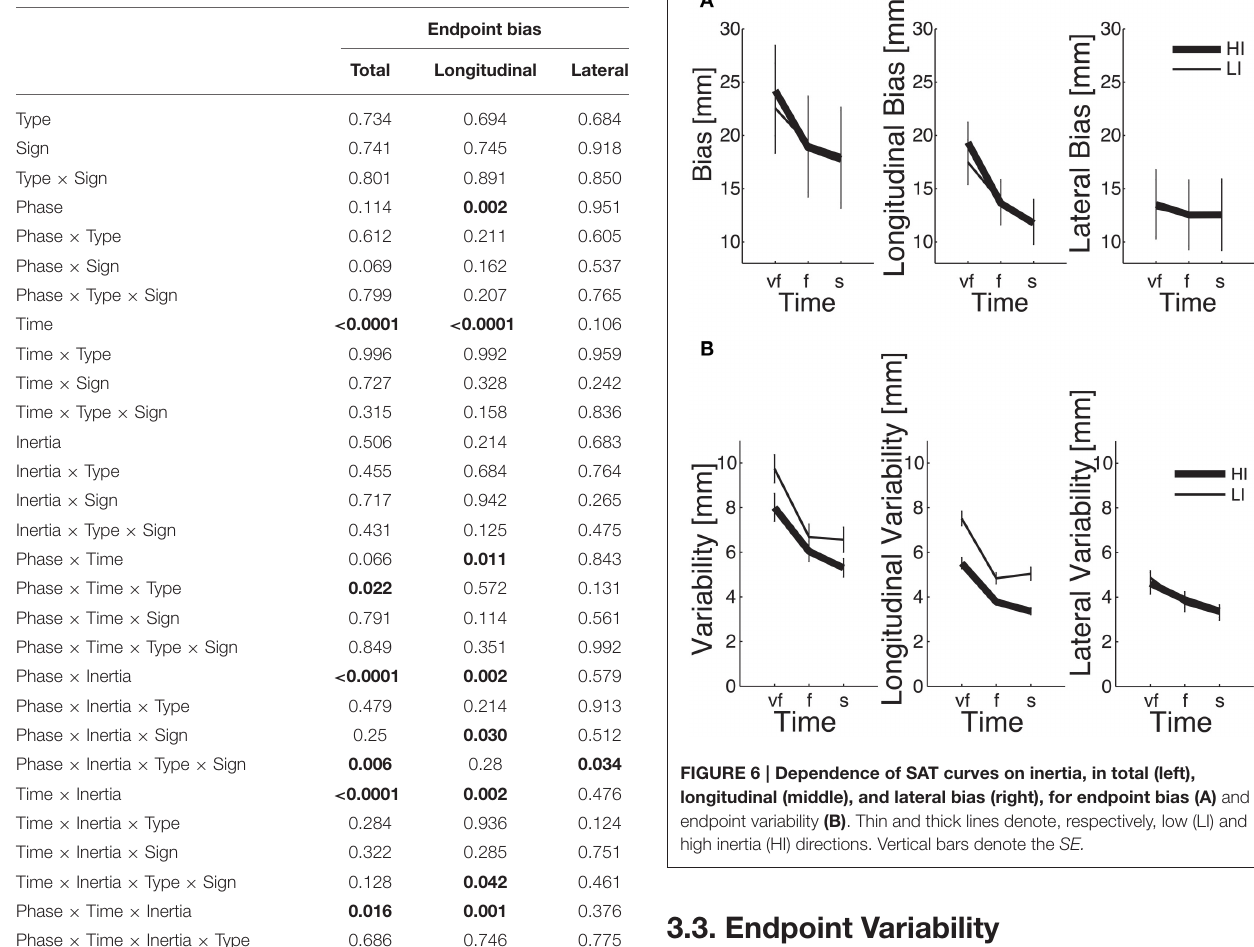
TABLE 2 | ANOVA table for endpoint bias.